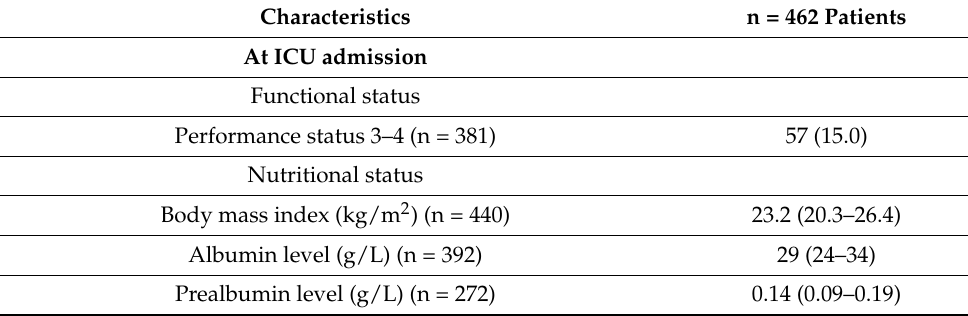
Table 2. Functional and nutritional